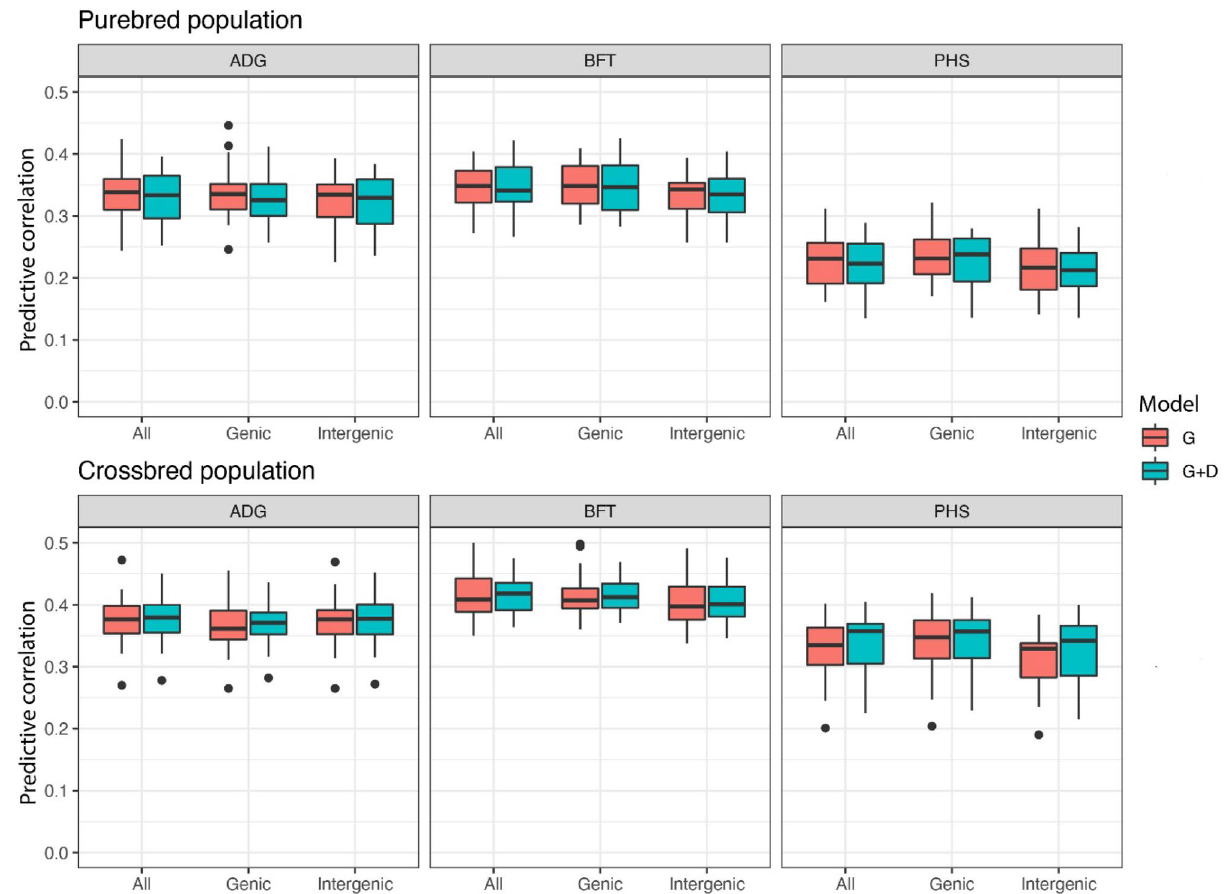
Figure 1. Boxplots of the predictive correlation obtained in the testing sets of fourfold cross-validations repeated ten times of a model with only additive genetic effects ( G ) and a model with additive and dominance genetic effects and inbreeding ( G + D ) using SNPs located in All, Genic and Intergenic regions in purebred and crossbred populations for average daily gain (ADG), backfat thickness (BFT) and pH of the semimembranosus muscle (PHS).